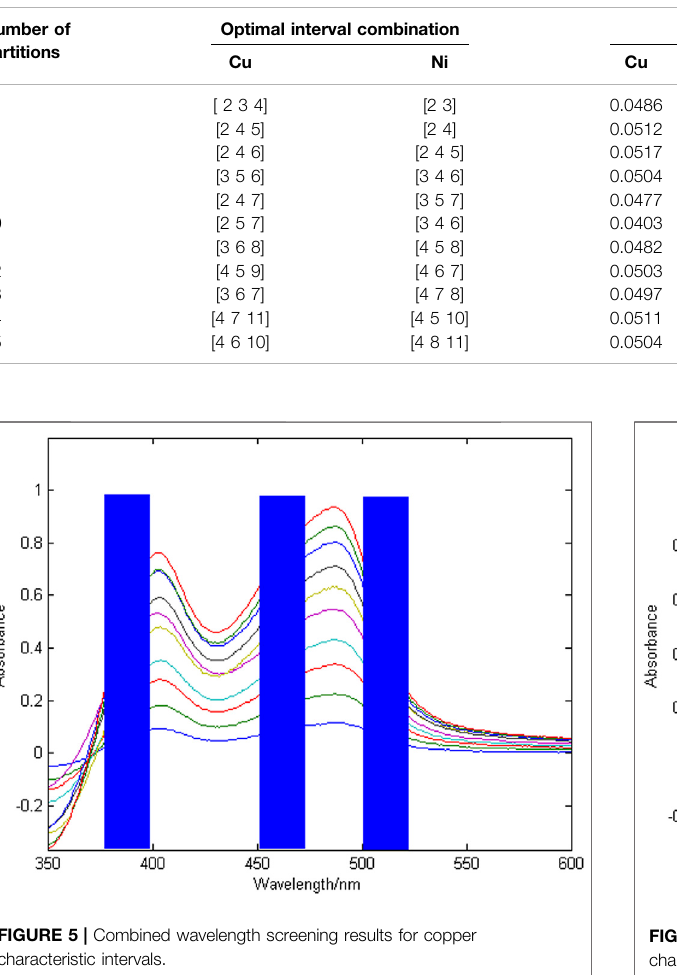
TABLE 2 | The optimal interval combination of copper and nickel after each interval division.